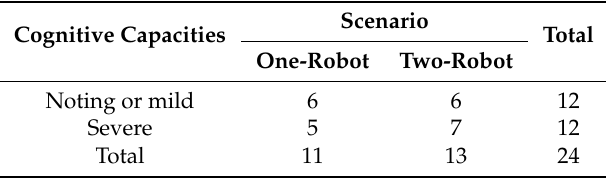
Table 2. Distribution of participants’ cognitive